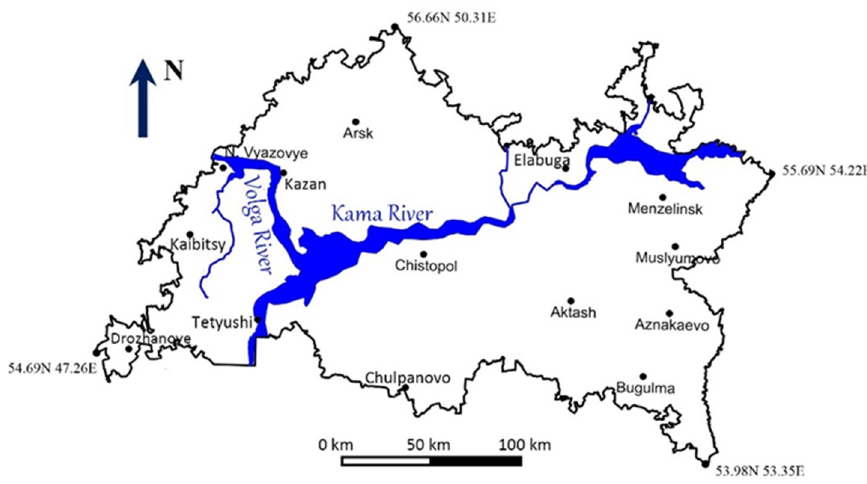
Figure 2. The analyzed meteorological stations in the Republic of Tatarstan, the Volga Federal District (European Russia, see Figure 1).